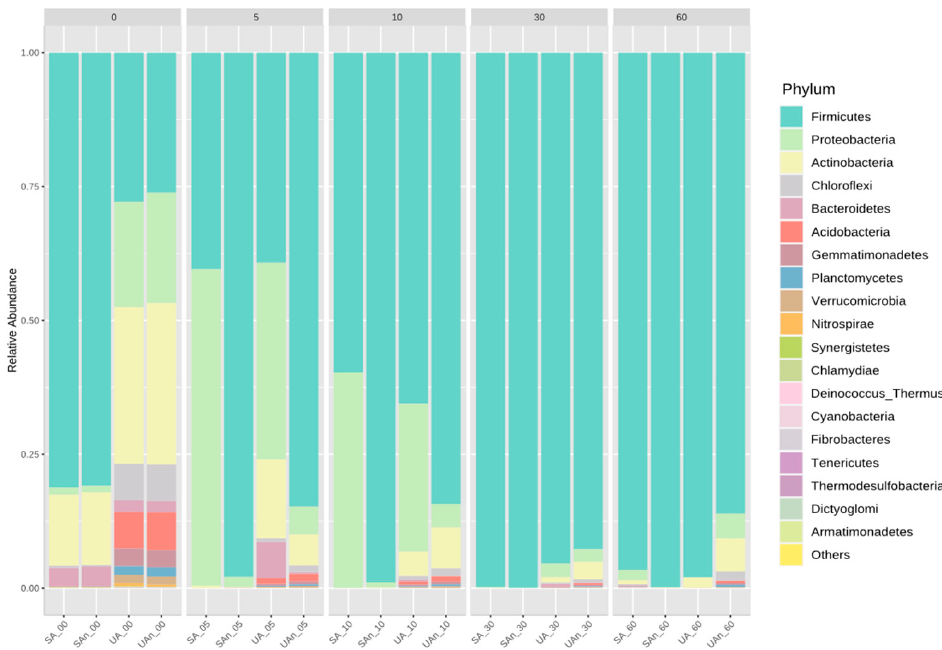
Figure 6. Relative abundance at phylum level during decomposition of poultry carcass. “Others” represent taxa with counts <10. UA, unsterilized soil–aerobic condition; SA, sterilized soil–aerobic condition; UAn, unsterilized soil–anaerobic condition and SAn, sterilized soil–anaerobic condition. The 0, 5, 10, 30, and 60 represent the sampling period.